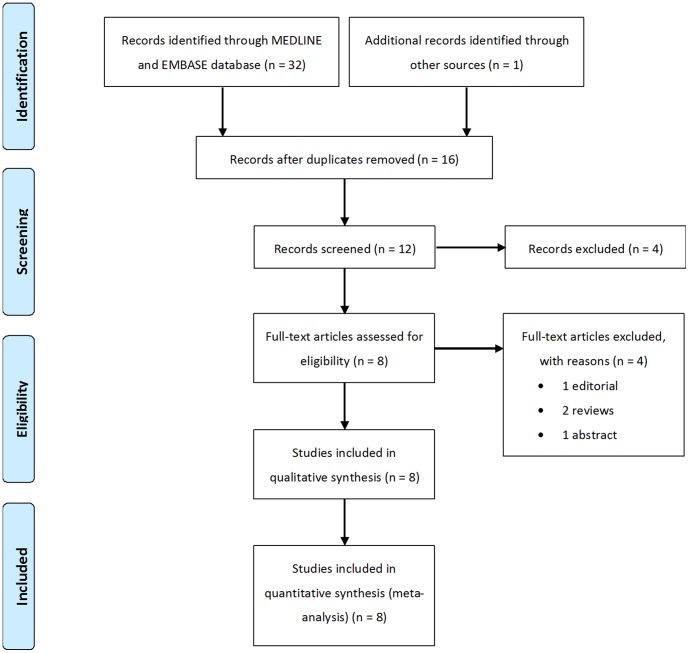
Flow diagram (modified from The PRISMA Flow Diagram) and results of literature review.Flow diagram depicted the screening process of retrieved articles, including the number and reason of exclusion.